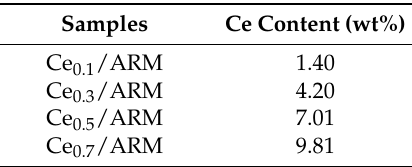
Table 5. Ce content in Ce/ARM